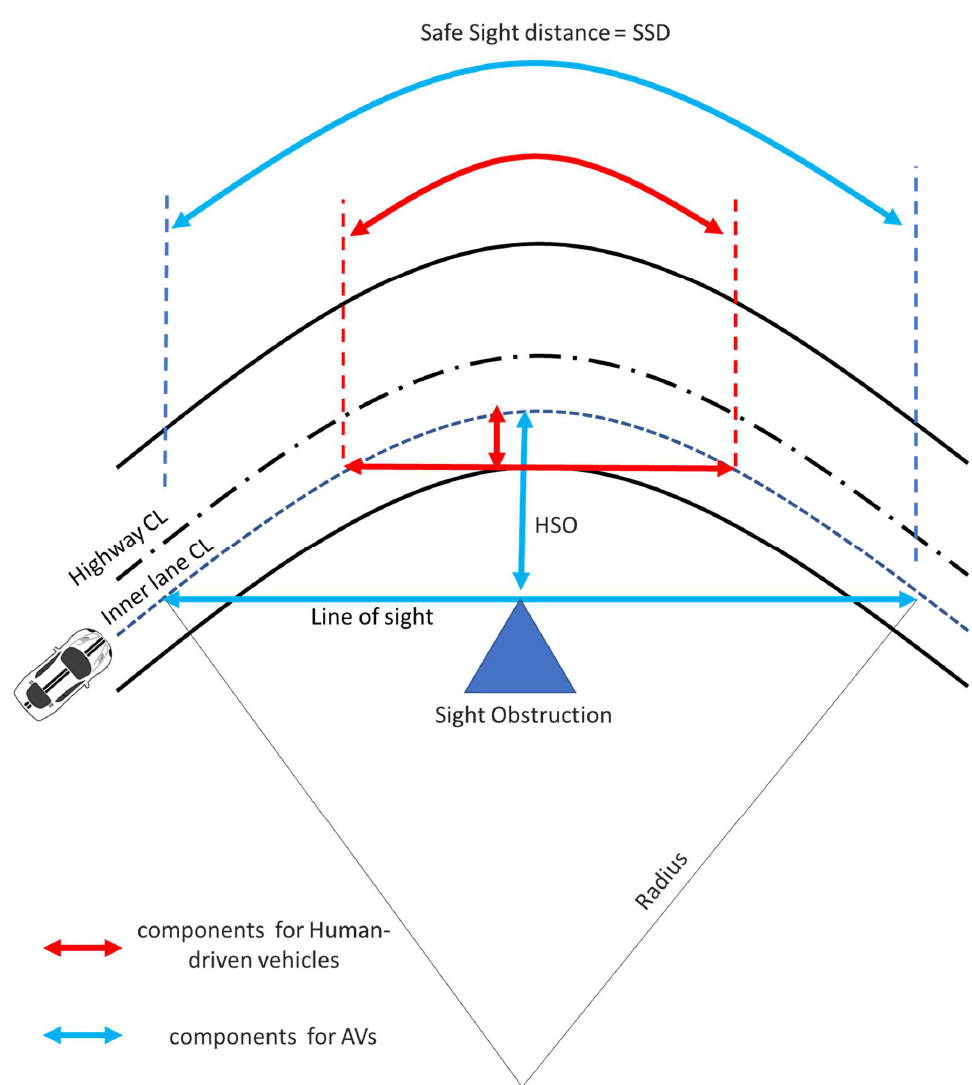
Figure 6. The difference between the components used for Determining Horizontal Sight Distance.